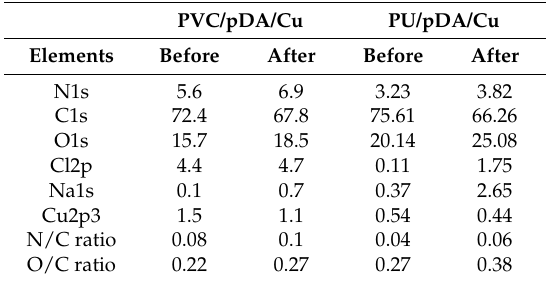
Table 2. Atomic composition of the Cu-modified PVC before and after incubation with 100 μ M Before After Before Before After